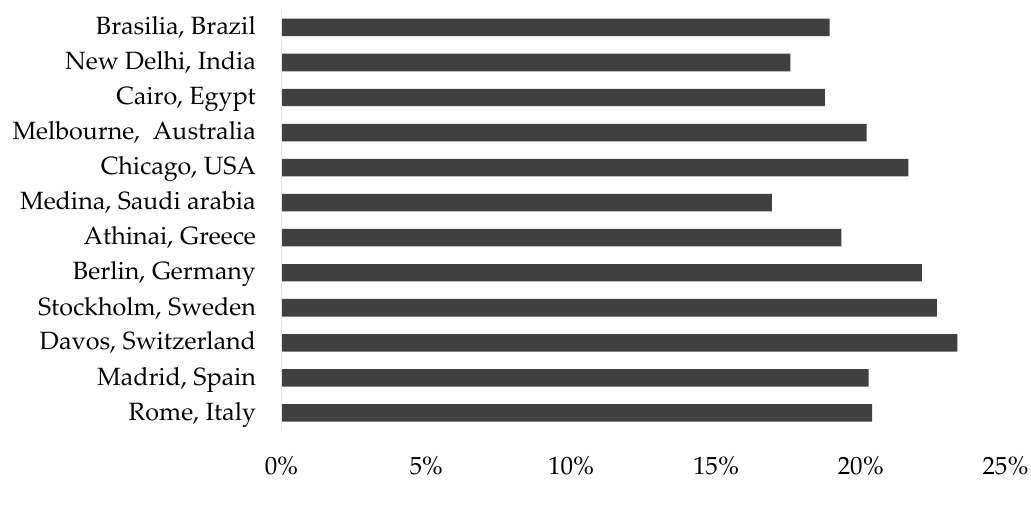
Figure 18. Collector exegetic efficiency.